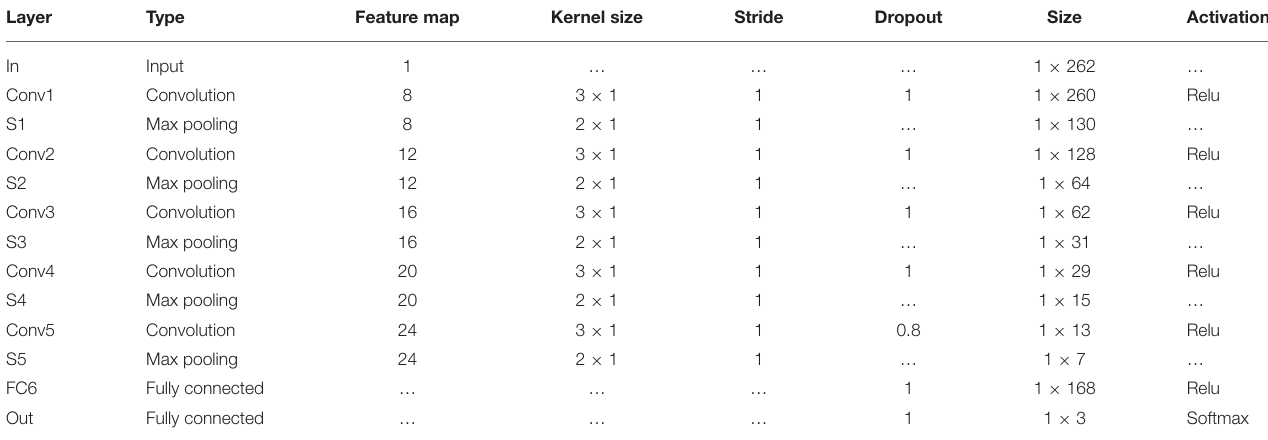
TABLE 1 | Parameters of each layer in 1D-convolutional neural network (CNN). Layer Type Feature